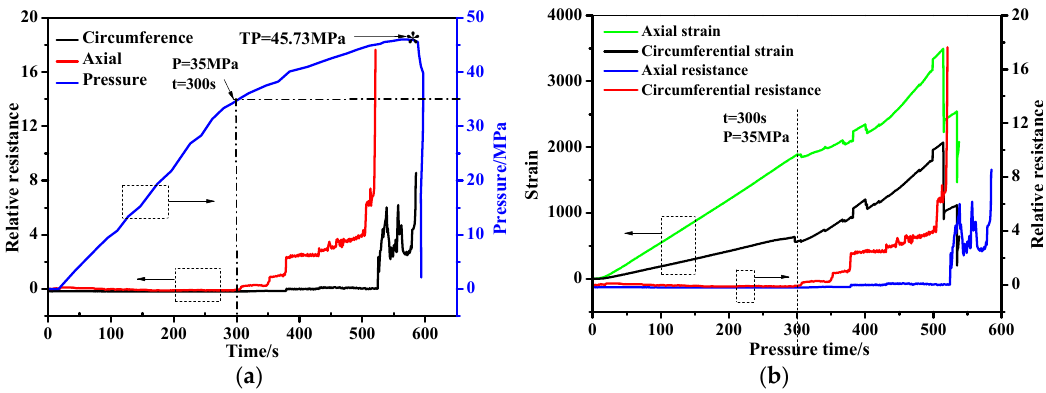
Figure 15. The in-situ monitoring of the filament wound pressure vessel (after hydraulic fatigue for 5700 cycles) during the blasting test. ( a ) Resistance, pressure–pressure time. ( b ) Resistance, strain–pressure time.